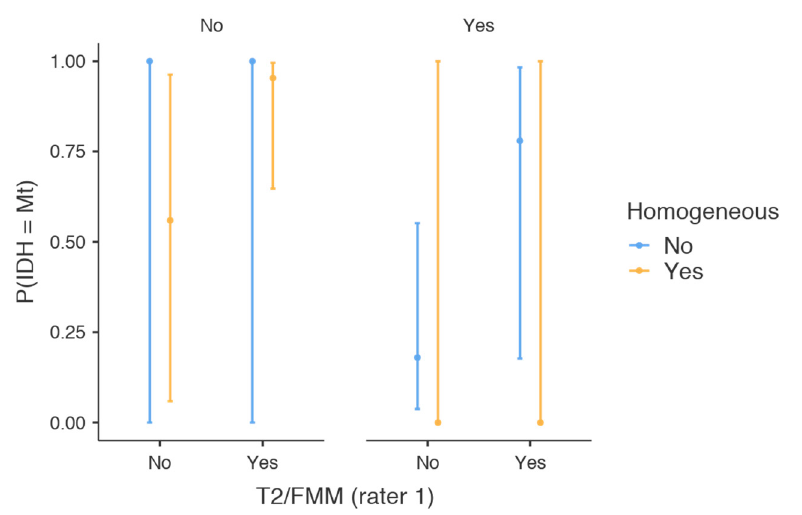
Figure 2. Marginal means plot of the full model. The probability of being IDH mutant in the presence of the T2–FLAIR mismatch sign and the absence of contrast enhancement was as high as 95.5% (95% CI 64.9–99.6%). Contrariwise, the probability of being IDH mutant in the absence of the T2–FLAIR mismatch sign with contrast enhancement was as low as 16.2% (95% CI 3.4–51.3%).